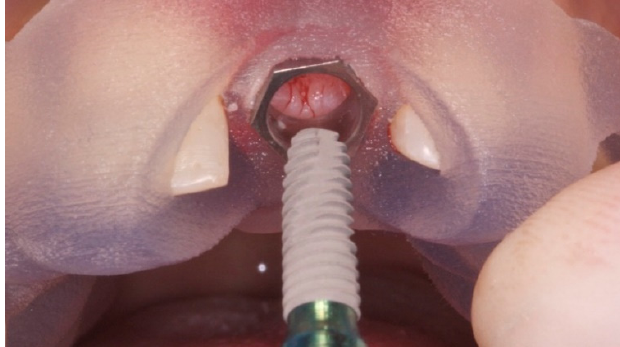
Figure 7. Guided implant placement four months after the socket preservation.